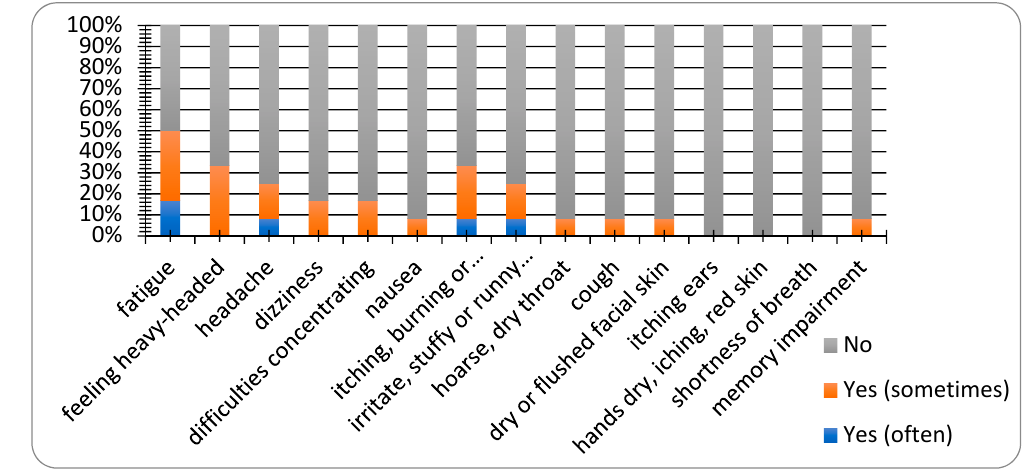
Figure 12. Evaluation of sick building syndrome (SBS) symptoms.